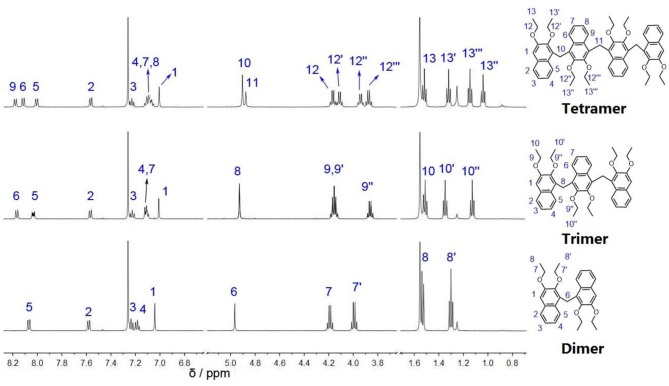
1H NMR spectra (500 MHz, 2.0 mM, CDCl3) of Dimer, Trimer, and Tetramer.